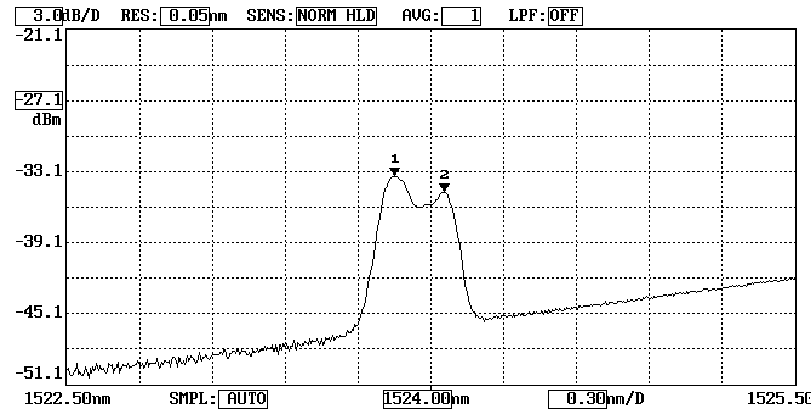
Figure 2. Optical spectrum reflected from the unbonded and bonded FBG due to a temperature of Δ T = 28.2 °C.